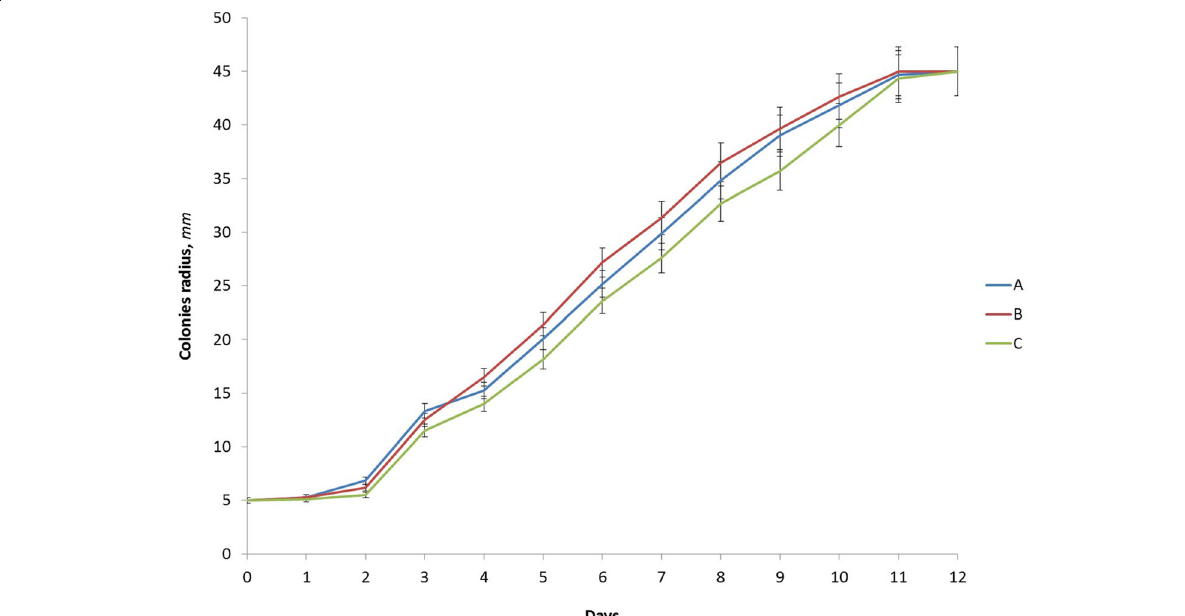
Fig. 4 The dynamics of changes in the radius of P. herpotrichoides colonies, grown on PDA with the addition of silver or copper nanoparticles: A control (without nanoparticles); B PDA media with Ag nanoparticles; C PDA media with Cu